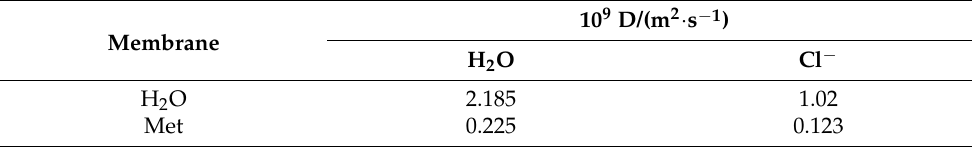
Table 5. Diffusion coefficients of H 2 O and Cl − in aqueous phase and Met films. Membrane